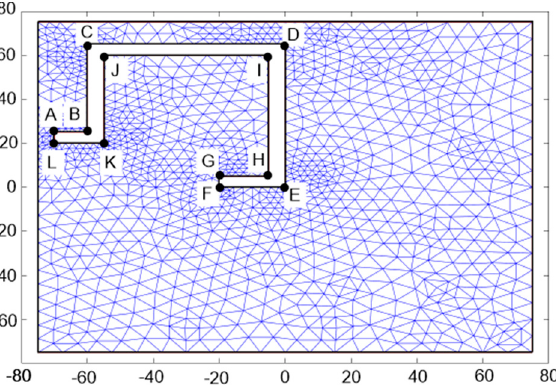
Figure 2. Modal analysis of the G-slot patch antenna by the finite-element method in the PDE tool of MATLAB.